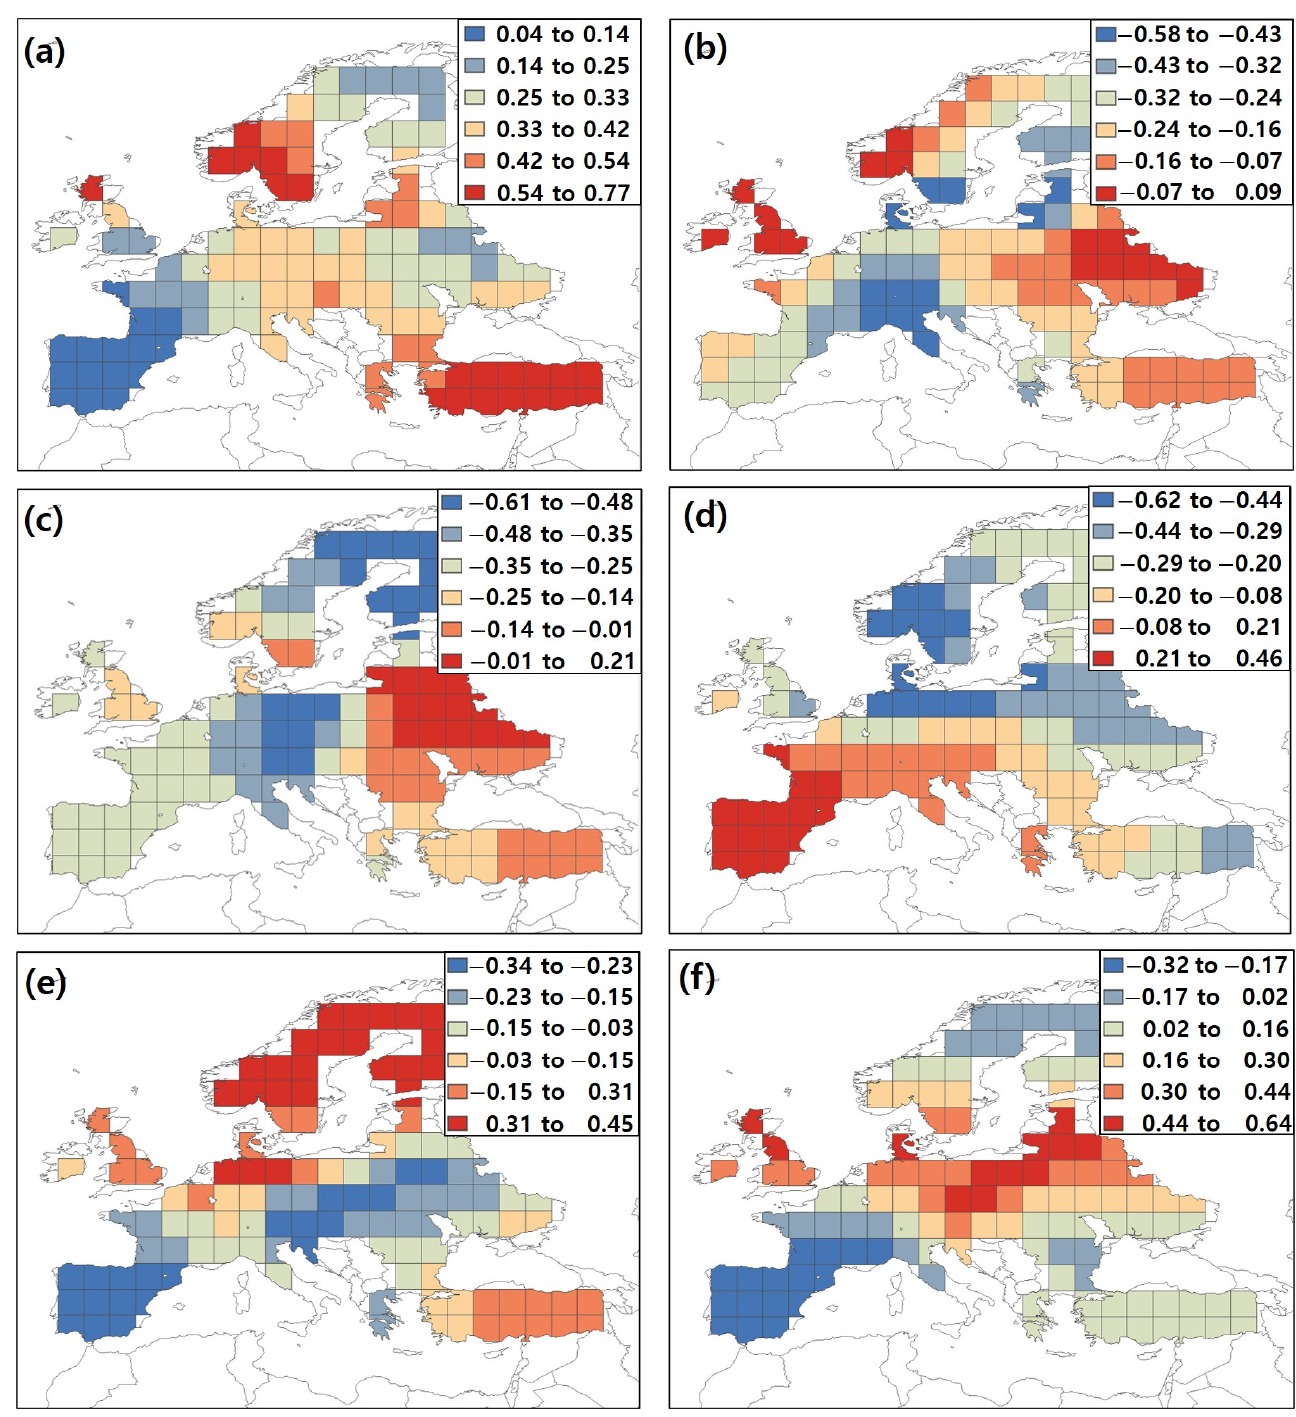
Figure 1. Regional mean of GWR local coefficient. ( a ) Temperature. ( b ) NDVI. ( c ) Fraction of photosynthetically active radiation (FPAR). ( d ) Leaf area index (LAI). ( e ) Average latent heat flux. ( f ) ODIAC-PSNet.